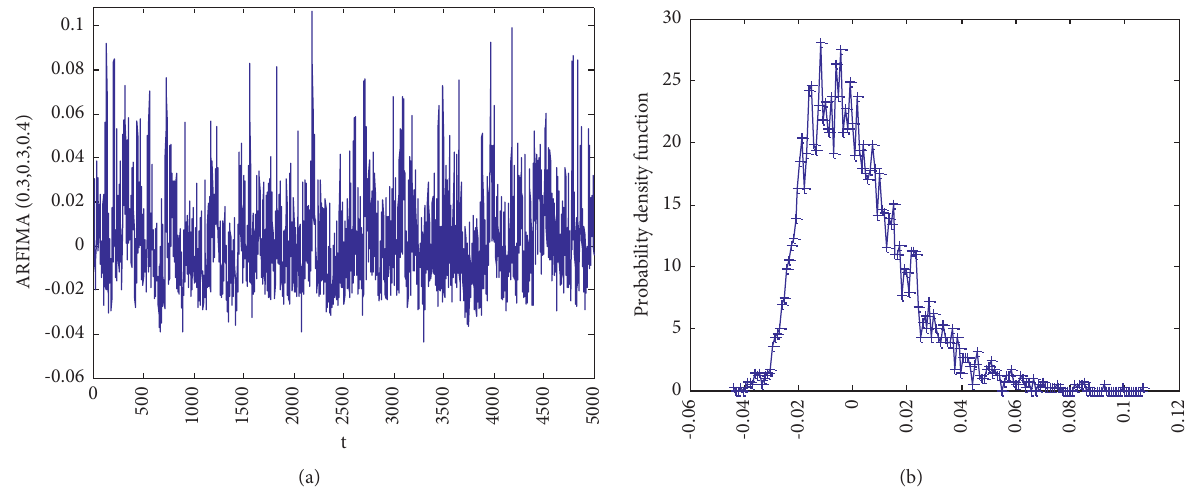
Figure 1: ARFIMA (0.3, 0.3, 0.4) process and probability